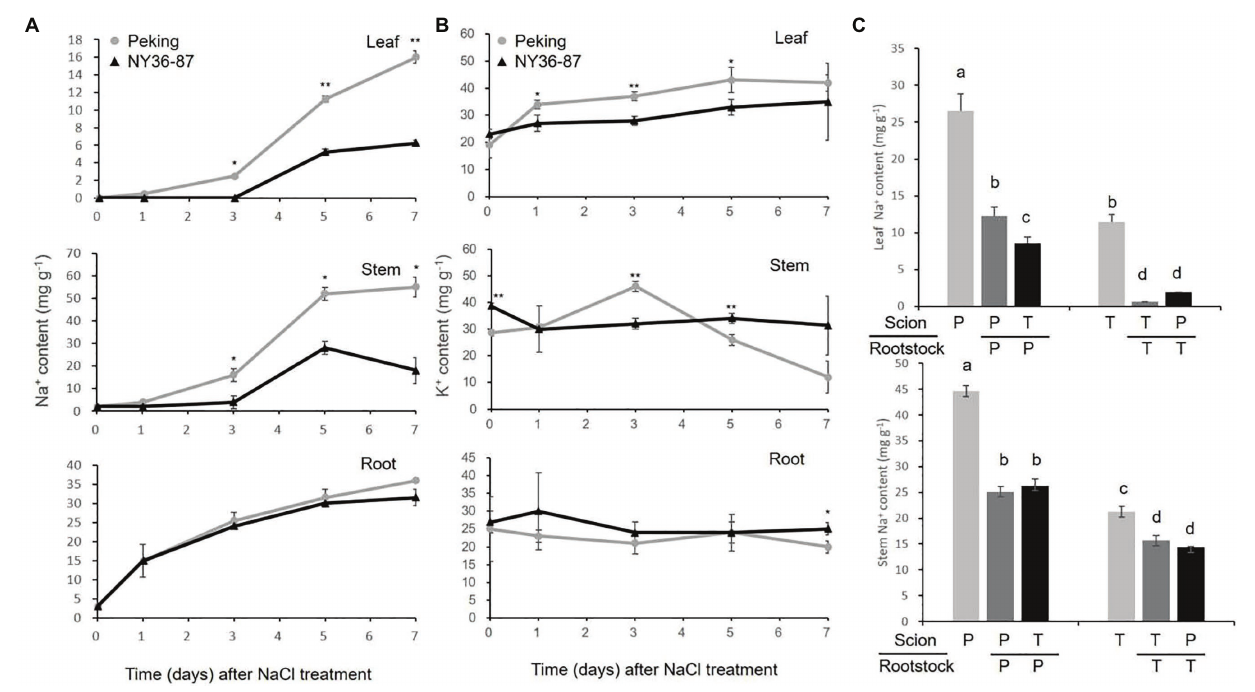
FIGURE 4 | Na + accumulation in Peking and salt-tolerant germplasm. (A) The Na + content in Peking (gray) and NY36-87 (black) under 200 mM NaCl stress for 0, 1, 3, 5, and 7 days. (B) The K + content in Peking (gray) and NY36-87 (black) under 200 mM NaCl stress for 0, 1, 3, 5, and 7 days. (C) The Na + content in leaf and stem of non-grafted and grafted soybean Peking (P) and Tiefeng 8 (T) after 10 days of salt stress. Letters indicate significant differences between samples. Data shown are the mean of three replicates ± SE. * p < 0.05, and ** p < 0.01. Different letters indicate statistically significant differences of ion content in different organs (one-way ANOVA using Fisher’s LSD test, p < 0.05)